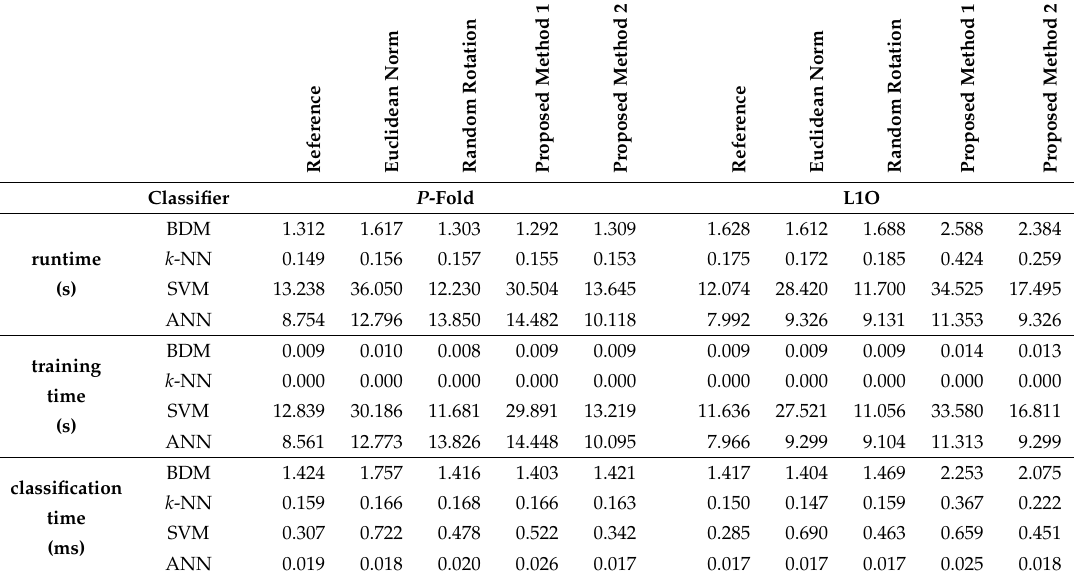
Table 3. Total runtime (training and classification of all test feature vectors), average training time per single cross-validation iteration, and average classification time per feature vector for dataset